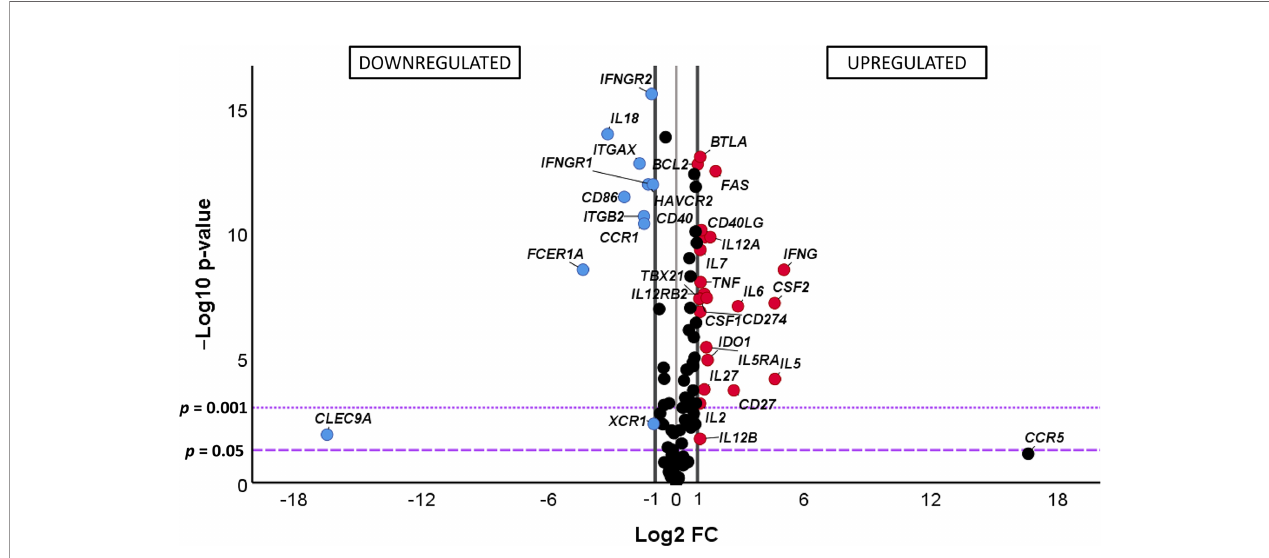
FIGURE 4 | (Comparative) analysis of the differential gene expression level of the 106 analyzed genes in chronic Chagas disease patients with the indeterminate form of the disease (IND) (n = 39) and healthy donors (HD) (n = 30). The x-axis represents log 2 of the expression fold change between IND and HD (Log 2 FC), where FC is calculated as the ratio between two groups (IND/HD). The y-axis corresponds to the statistical signi fi cance, expressed as the negative logarithm of the p -value (-Log 10 p -value). The purple horizontal lines indicate the cutoffs for the statistical signi fi cance (corresponding to p = 0.05 and p = 0.001). The black vertical lines represent the log 2 FC of − 1 and 1 (corresponding to FC of 0.5 and 2, respectively) used as biological thresholds established to identify differentially expressed genes. The negative values correspond to downregulated genes (blue dots) and the positive values to the upregulated genes (red dots) in IND patients compared to HD. Black dots represent non-differentially expressed genes.